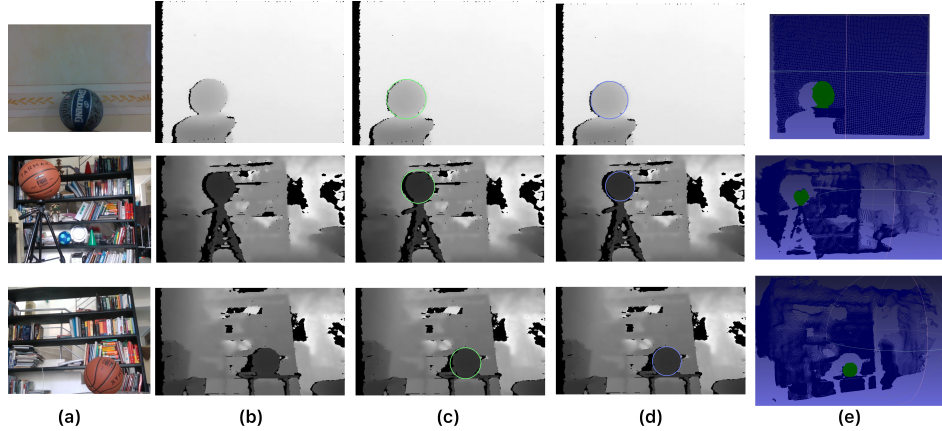
Figure 21. ( a ) RGB scene, ( b ) 3D point cloud reprojection to 2D image, ( c ) CircleNet detection, ( d ) Our sphere detection reprojected to a circle in 2D image, and ( e ) our sphere detection directly in 3D point cloud. Mean Average Precision (mAP) [42] is used in Table 3 as a metric. To obtain cIOU values from the proposed method, the sphere center was re-projected to 2D and with the sphere radio the sphere center was reprojected to the left at same depth to compute a circle in the 2D re-projection. Table 3. Comparison with other